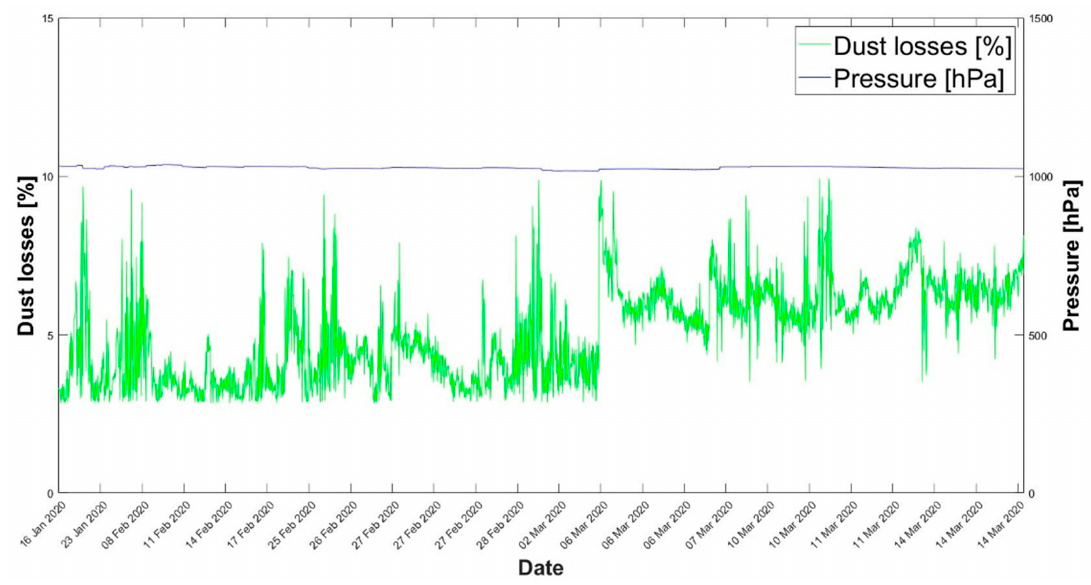
Figure 10. Variation in the production loss associated with dust and the pressure at the experimental plant during the measurement campaign.